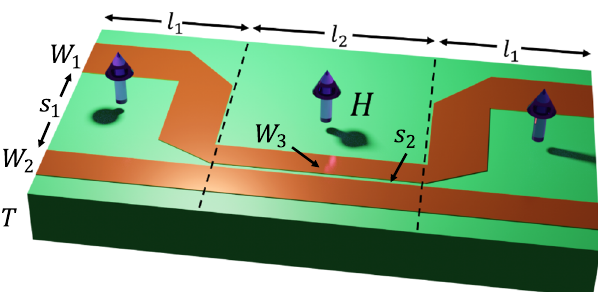
Fig. 6 The simulated unit-cell of the SIP platform. The platform consists of a board made of a magnetic material (green), which hosts two coupled microstrip waveguides (brown). The vertical purple arrows indicate the applied magnetic fi eld H , Here 2 l 1 and l 2 are the lengths of uncoupled and coupled sections of the waveguide, W 1 and W 3 are the widths of the meandered waveguide in the uncoupled and coupled sections, W 2 is the width of the straight waveguide, T is the thickness of the magnetic substrate, s 1 and s 2 are the separation distances between the waveguides in the uncoupled and coupled sections respectively. Parameter values used